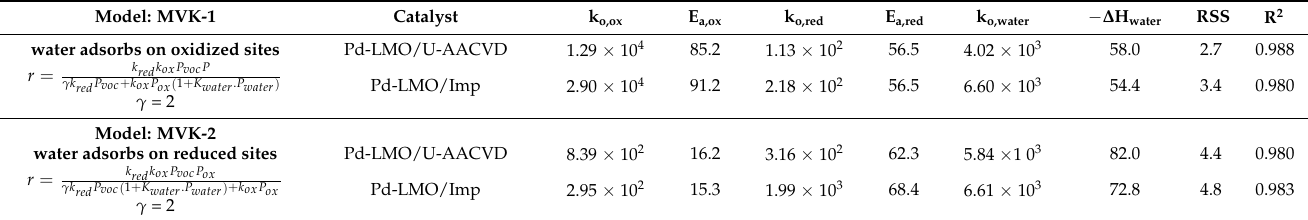
Table 5. Reaction rate expressions and kinetics parameters for applied MVK—models.